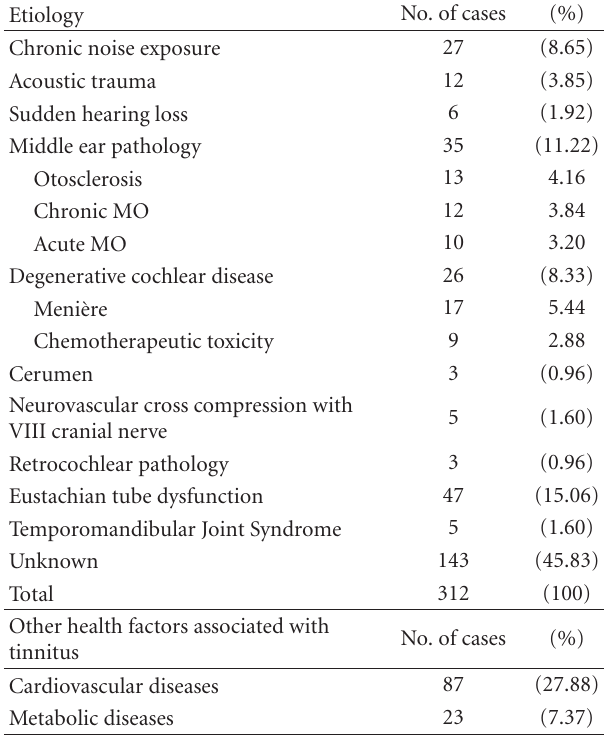
Table 3: Tinnitus characteristics of the 312